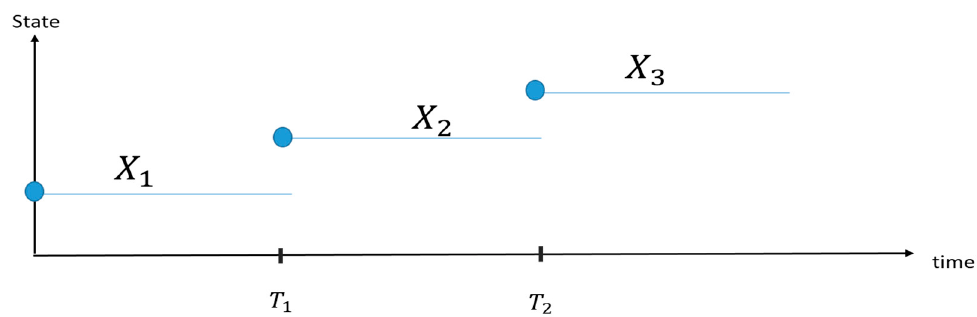
Figure A1. Sample path of a semi-Markov process.